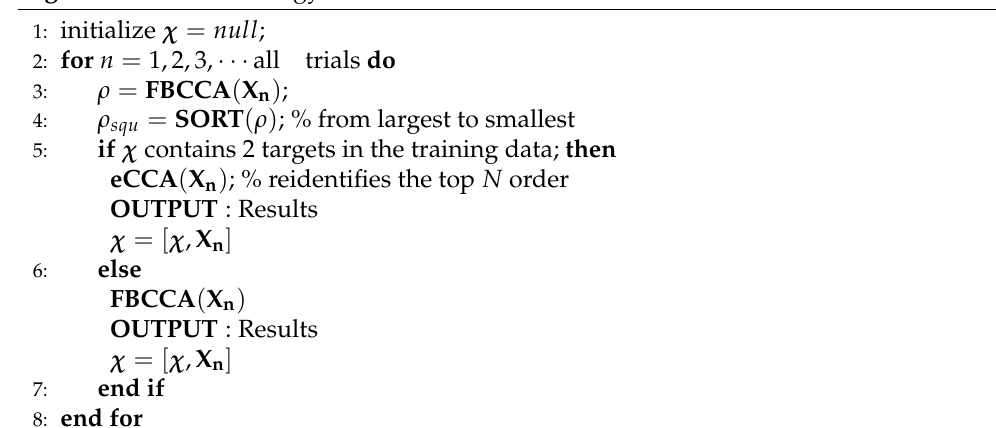
Algorithm 1 Turbo strategy for SSVEP-based